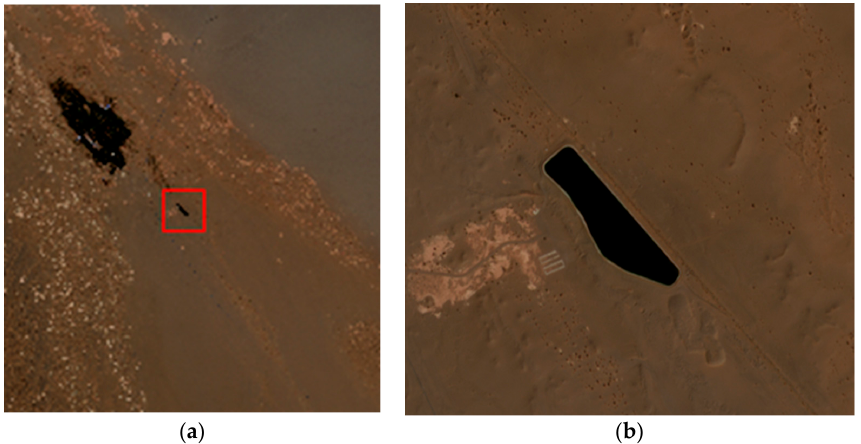
Figure 10. ( a ) Select Water1 area (in the red box) and its surrounding environment (Gobi background); ( b ) enlarged Water1 area (the area is about (76.48 × 128.06) m 2 ).